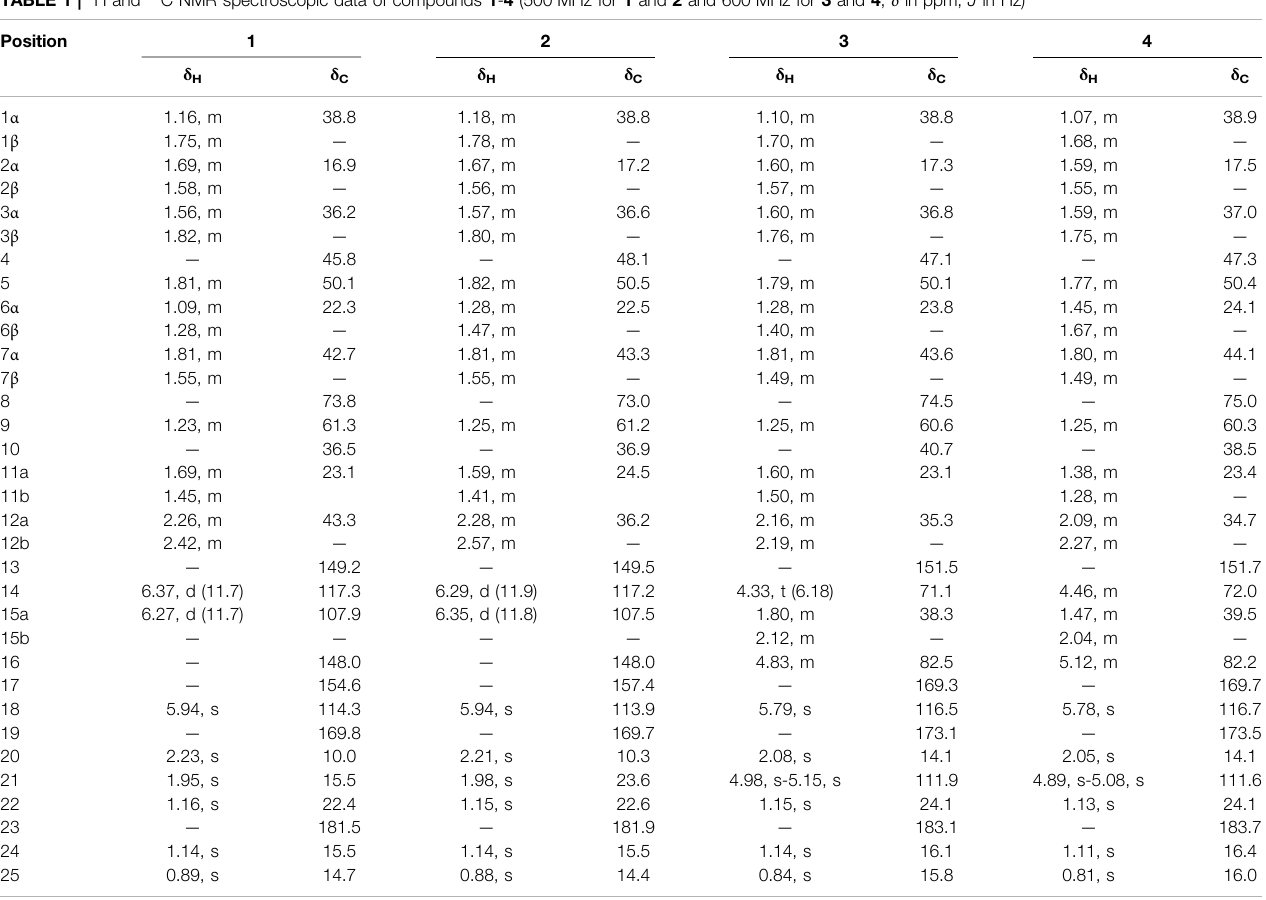
TABLE 1 | 1 H and 13 C NMR spectroscopic data of compounds 1 - 4 (500 MHz for 1 and 2 and 600 MHz for 3 and 4 , δ in ppm, J in